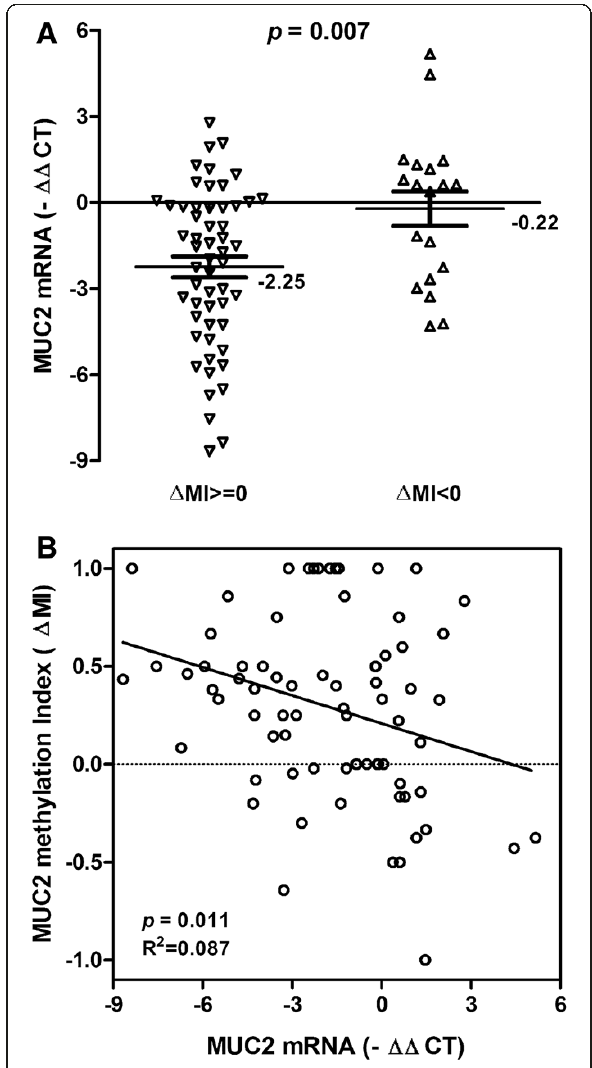
Figure 3 MUC2 mRNA and promoter methylation in HCC patients. ( A ) MUC2 mRNA expression were lower in HCC patients with Δ MI>= 0 than those with Δ MI <0. Statistical analyses were done using the unpaired t test. ( B ) The scatter plots summarized relative expression levels of MUC2 mRNA ( − ΔΔ CT) associated with relative methylation index ( Δ MI) in HCC patients. Statistical analyses were done using Pearson correlation test. - ΔΔ CT, - ( Δ CT HCC - Δ CT Non-HCC ); Δ MI, MI HCC -MI Non-HCC .